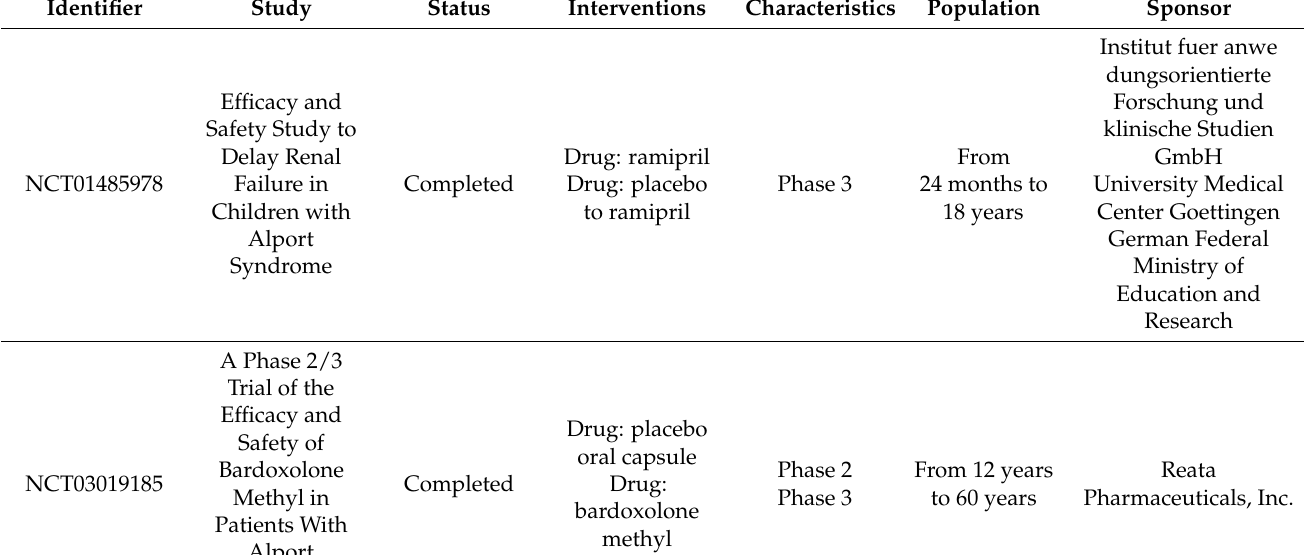
Table 2. Clinical trials that have tested the efficacy of drugs for the treatment of Alport syndrome and their current status.